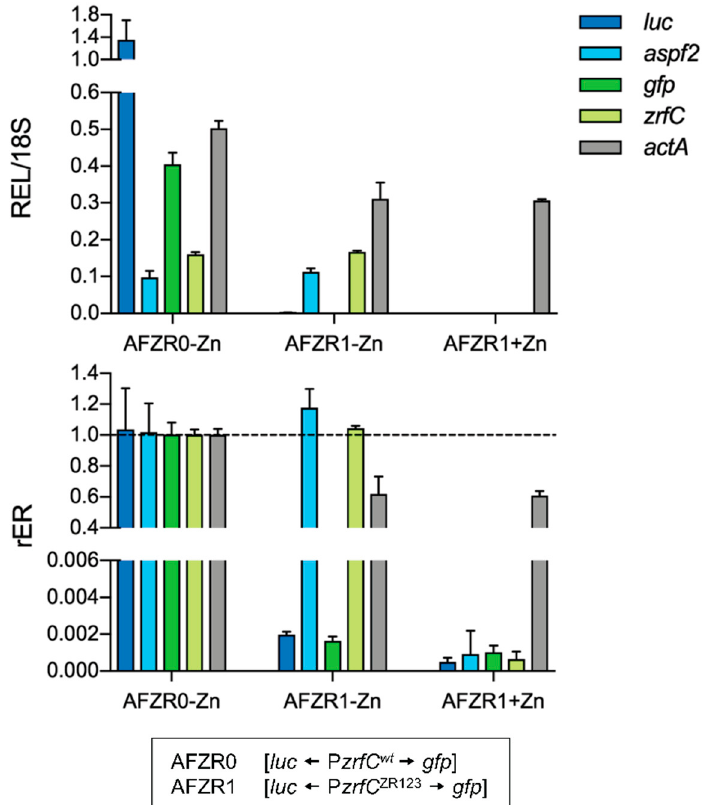
Figure 7. Effect of mutations in the conserved hexanucleotide core of the ZR consensus motif on ZafA binding in vivo. (Upper panel) Relative expression levels (REL) of endogenous aspf2 and zrfC genes and their corresponding reporter genes ( luc and gfp ) driven by a wild-type (in the AFZR0 strain) and mutant version (in the AFZR1 strain) or the divergent aspf2-zrfC promoter (abbreviated as P zrfC ). In the mutant version of this promoter the three ZR motifs present in it (P zrfC ZR123 ) had been inactivated by site-directed mutagenesis. Both strains were cultured under zinc-limiting conditions in SDN–Zn for 20 h at 37 °C. The AFZR1 strain was also grown under zinc-replete conditions in SDN + 100 µM Zn to be used as a control of the effect of zinc on the transcriptional activity of ZafA on P zrfC wt . (Lower panel) Relative expression ratio (rER) of data represented in the upper panel after their normalization with respect to the expression level in the AFZR0 strain grown under zinc-limiting conditions. The expression level of the actin gene was also measured by RT-qPCR as an additional control. The 18S rRNA was used as an internal reference for all relative quantifications.